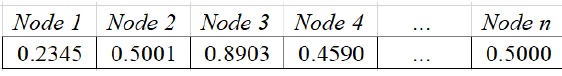
Figure 4. Example of chromosome.